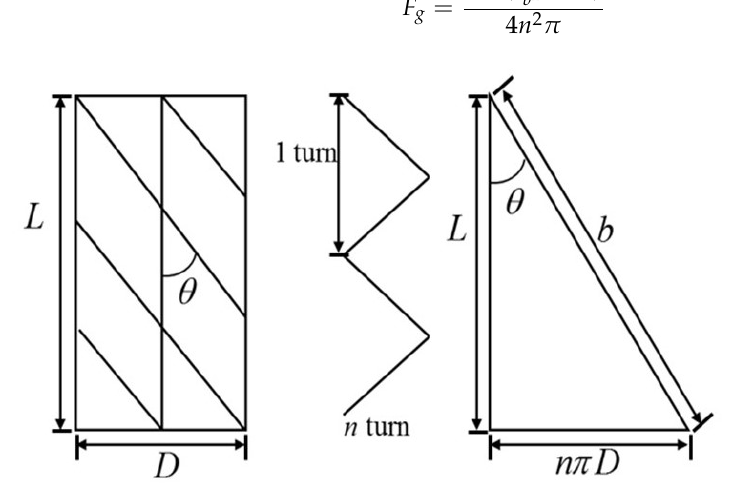
Figure 9. Simplified geometrical model of